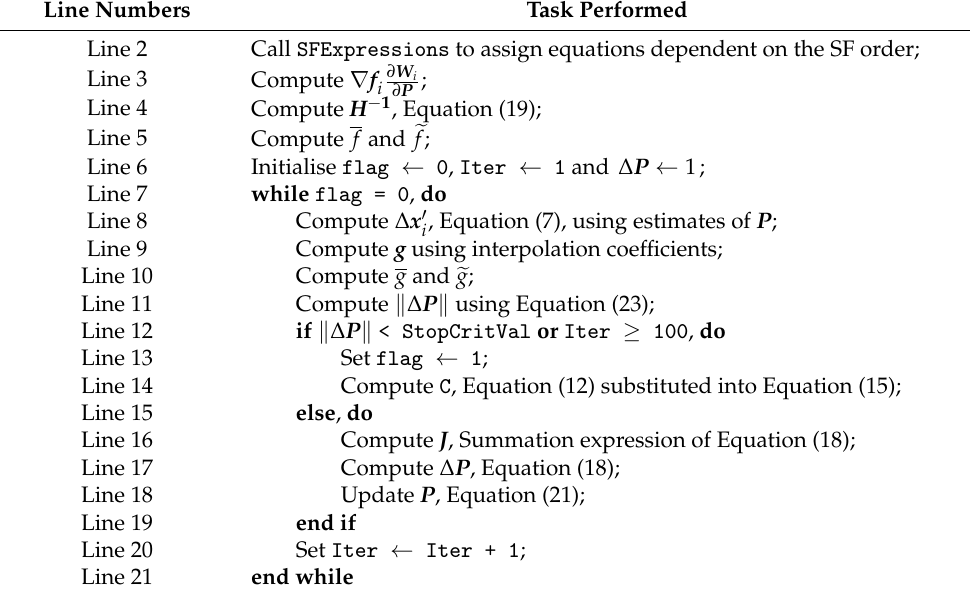
Table 8. SubCorr algorithm